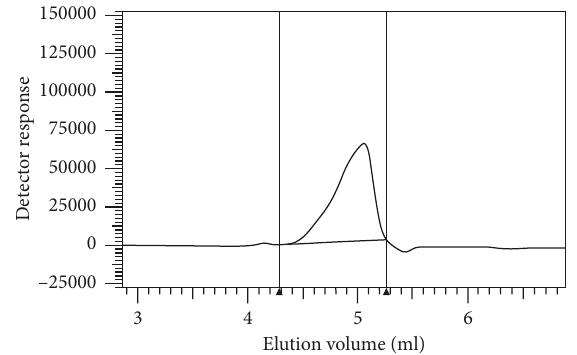
Figure 5: GPC thermogram of the